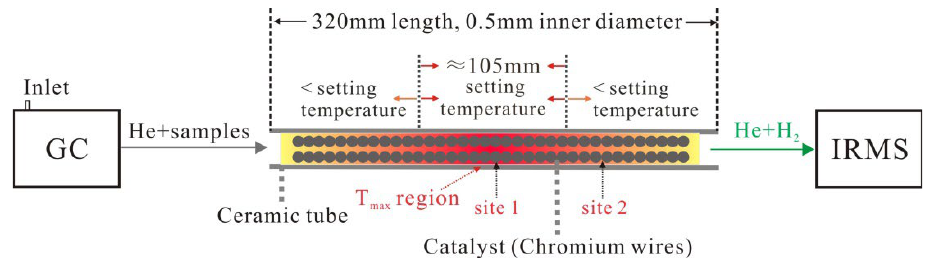
Figure 3. Schematic diagram of the Cr/HTC reactor and an indication of the XPS test sites.